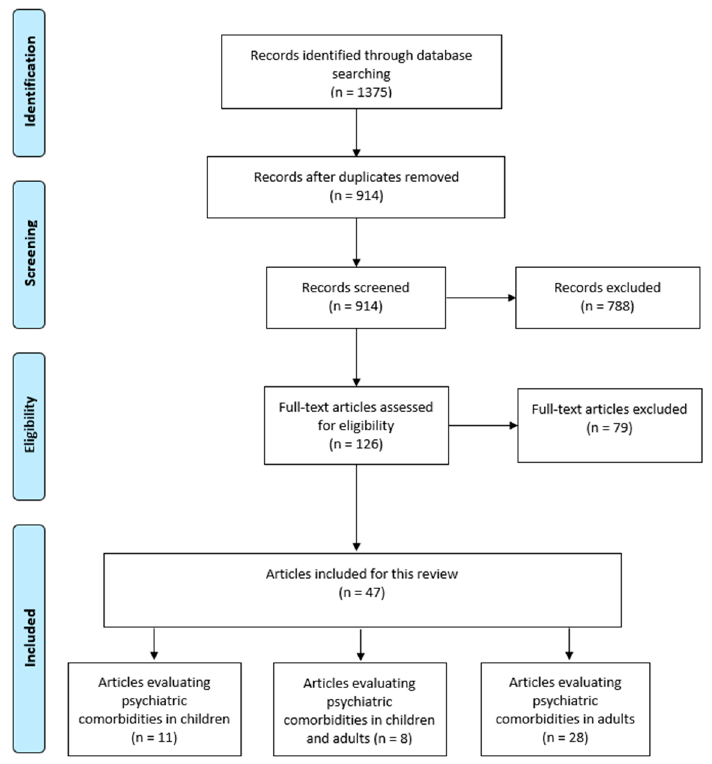
Figure 1. PRISMA flow chart.